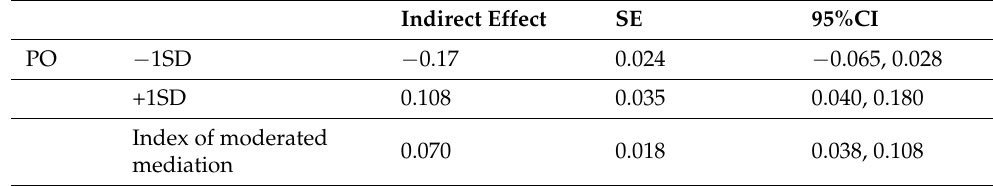
Table 5. Results of the moderated indirect